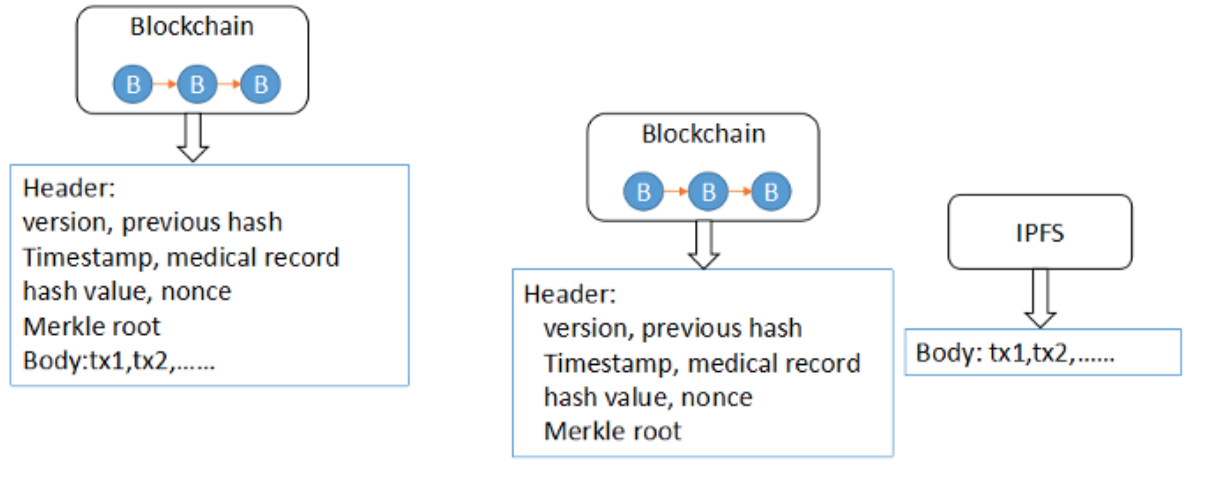
Figure 2. Blockchain structure. (A) Traditional blockchain structure. (B) Horizontal blockchain structure. IPFS: InterPlanetary File System; tx: text.